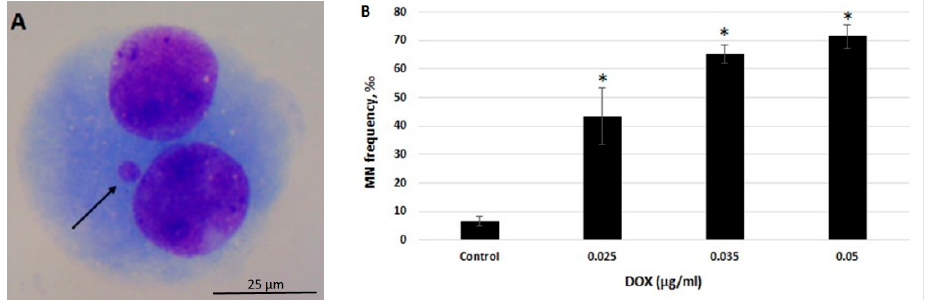
Figure 1. Genotoxic effect of doxorubicin (DOX) as analyzed by cytokinesis-block micronucleus (CBMN) assay in human peripheral blood lymphocytes. ( A ) Representative image of the binucleated cell with micronuclei (MN) (MN is indicated by the arrow; 100× oil objective, Giemsa staining). ( B ) Frequency of micronuclei in human peripheral blood lymphocytes treated with DOX at concentrations 0.025, 0.035, and 0.05 µg/mL. Statistically significant increase in MN levels is indicated at * p < 0.05. Scale bar = 25 µm